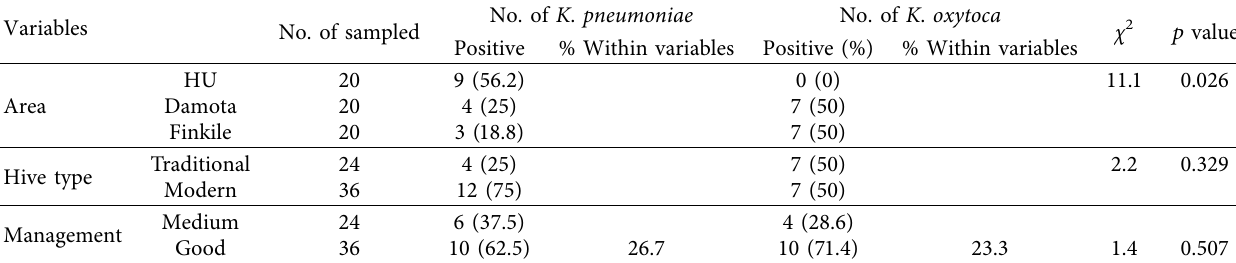
Table 1: The apiculture-related risk factors for the occurrence of Klebsiella spp. Variables